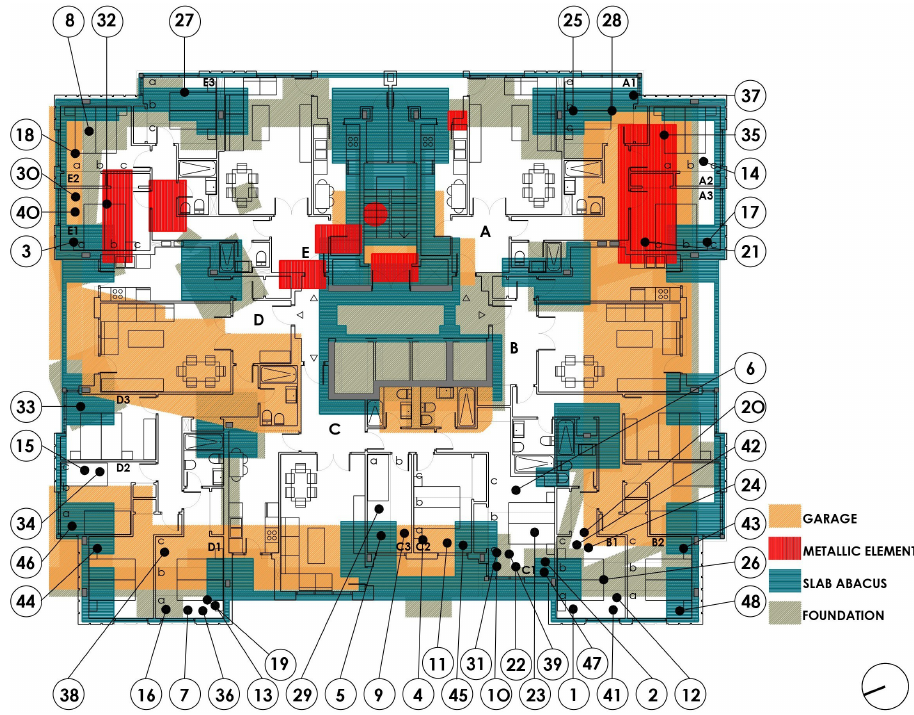
Figure 9. Floor plan dwellings type 1 to 16. Overlapping all metallic elements.